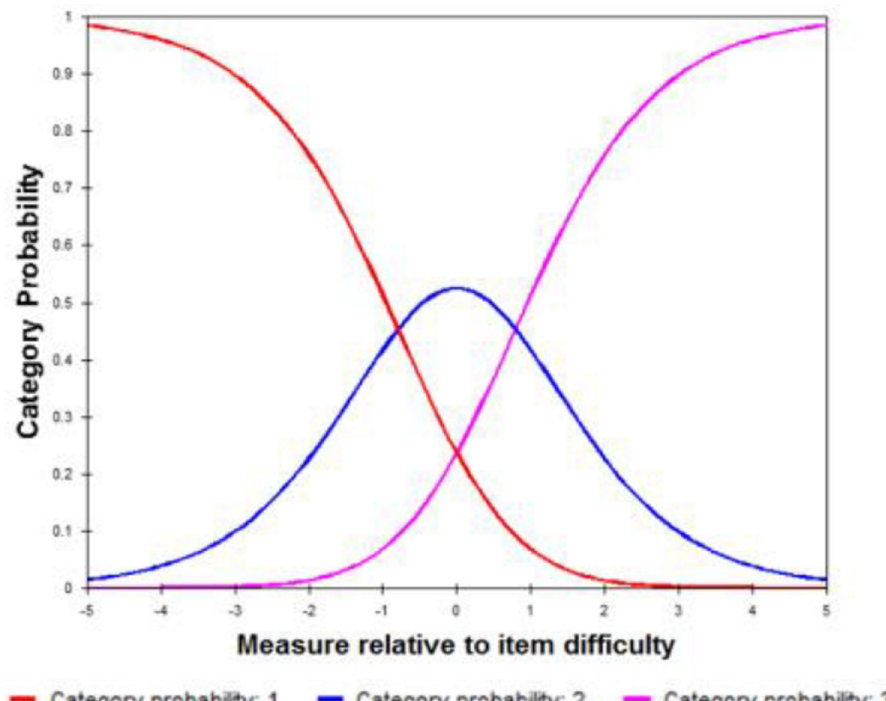
Fig 3. Category probability curve for eCAPS